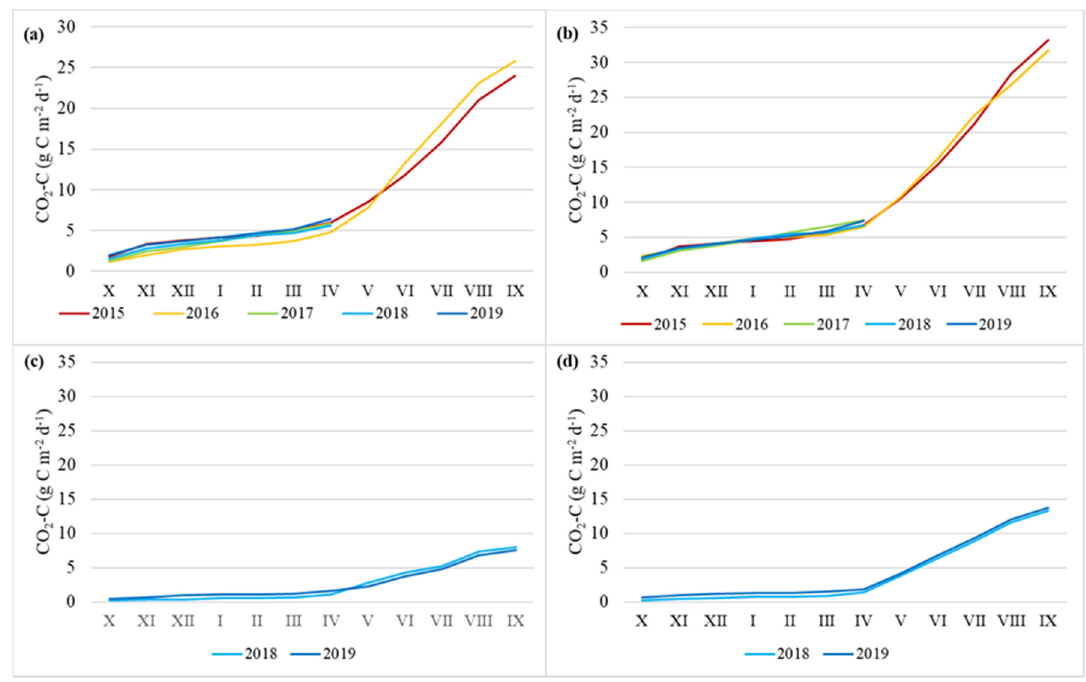
Figure 4. Cumulative annual CO 2 -C emissions at Norway spruce ( a ) and Downy birch ( b ) drained peatland forests and Ess-soo ( c ) and Laiuse ( d ) abandoned peat extraction areas.